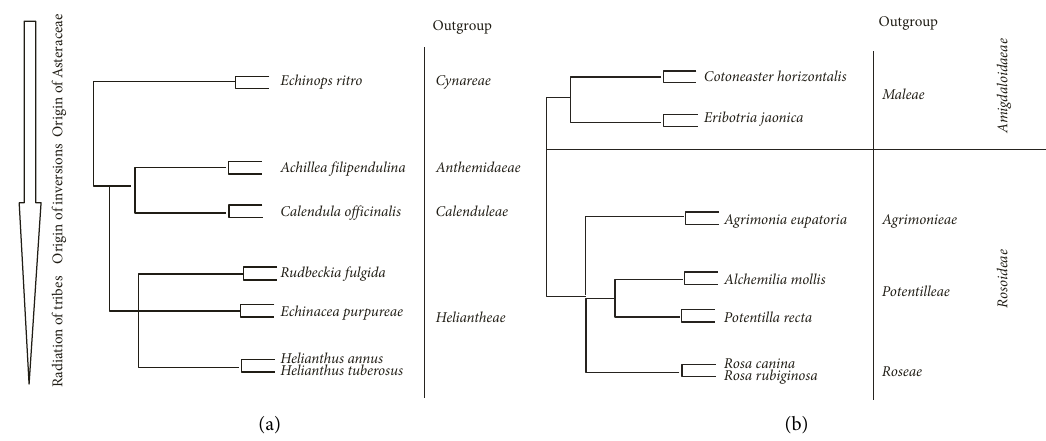
Figure 7: Presentations of phylogeny trees studied representatives’ families Asteraceae (a) and Rosaceae